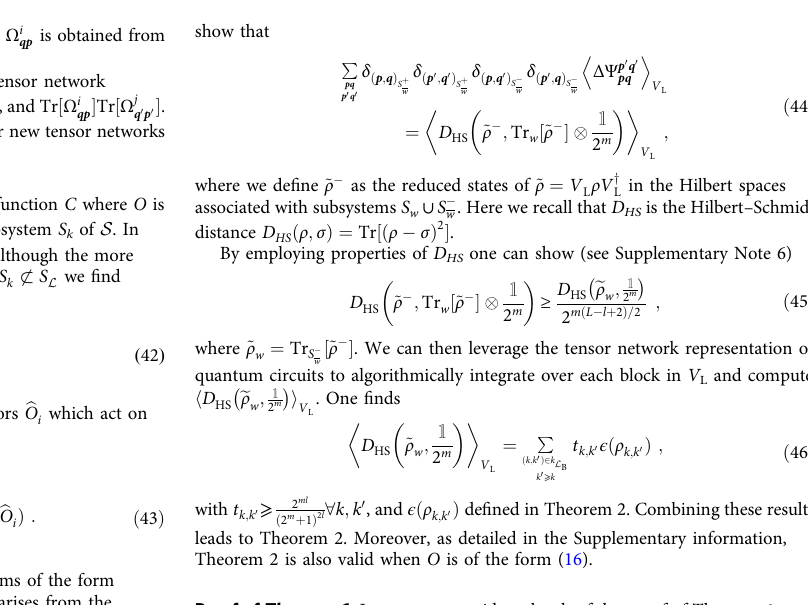
q j i p h j . We also show the representation of Tr ½ Ω i Ω j pq ¼ q 0 p 0 (cid:3) qp R d μ ð W Þ Tr ½ Ω i Ω j q 0 p 0 (cid:3) and R qp ΔΩ q 0 p 0 as in Eq. (31). c As shown in the Supplementary Note 1, the result of the integration is a qp i V R